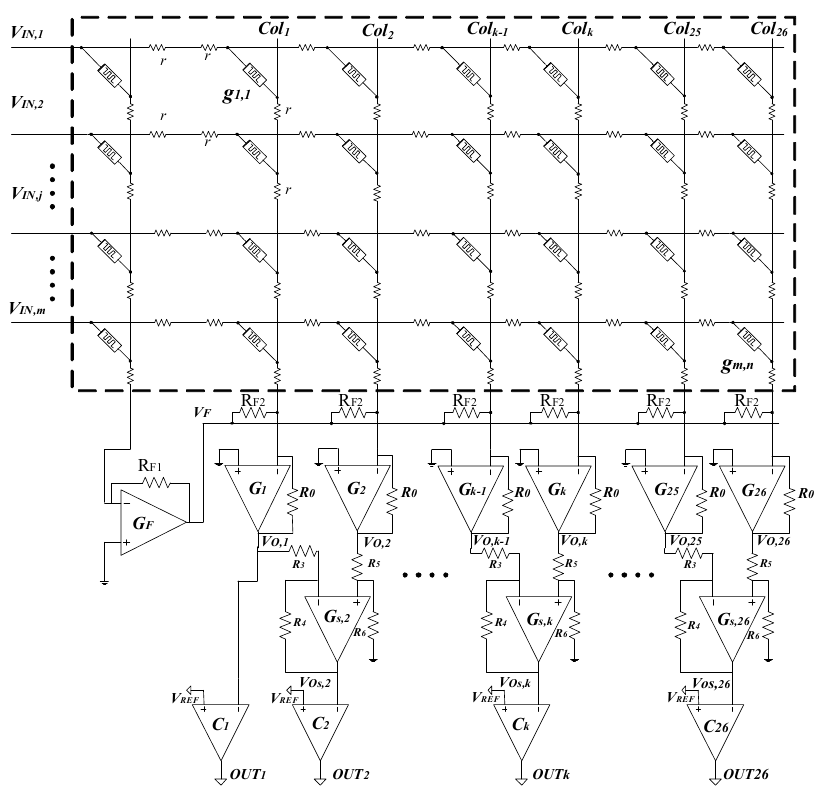
Figure 3. The proposed memristor crossbar with compensating circuit for implementing a perceptron neural network. The outputs of two adjacent columns are put into a differential amplifier working as a subtractor to eliminate the output voltage variation.